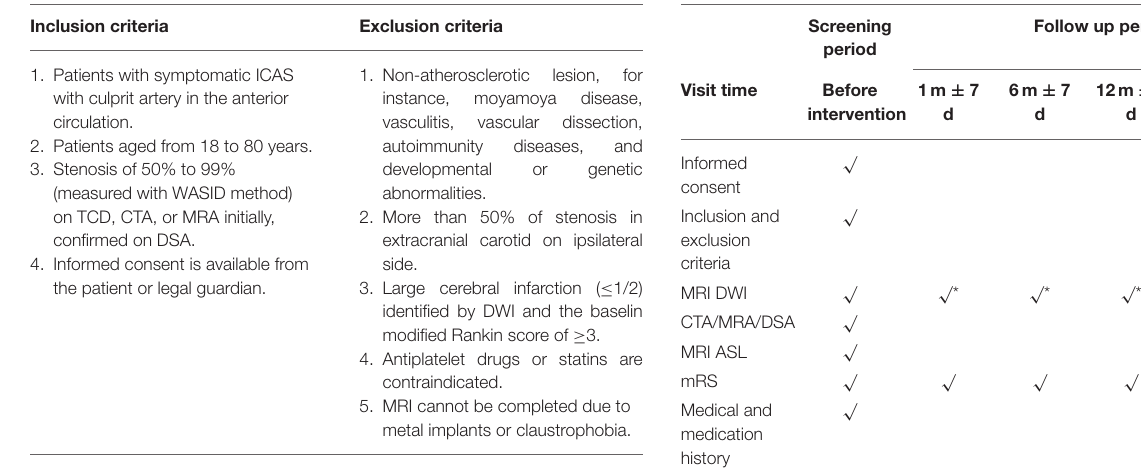
TABLE 3 | The planning of the